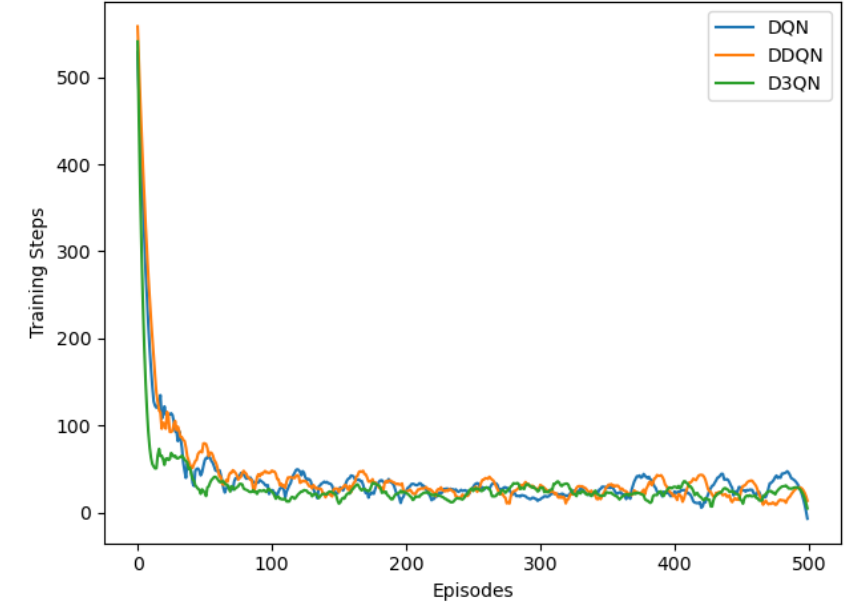
Figure 2. The comparison of convergence performance among different